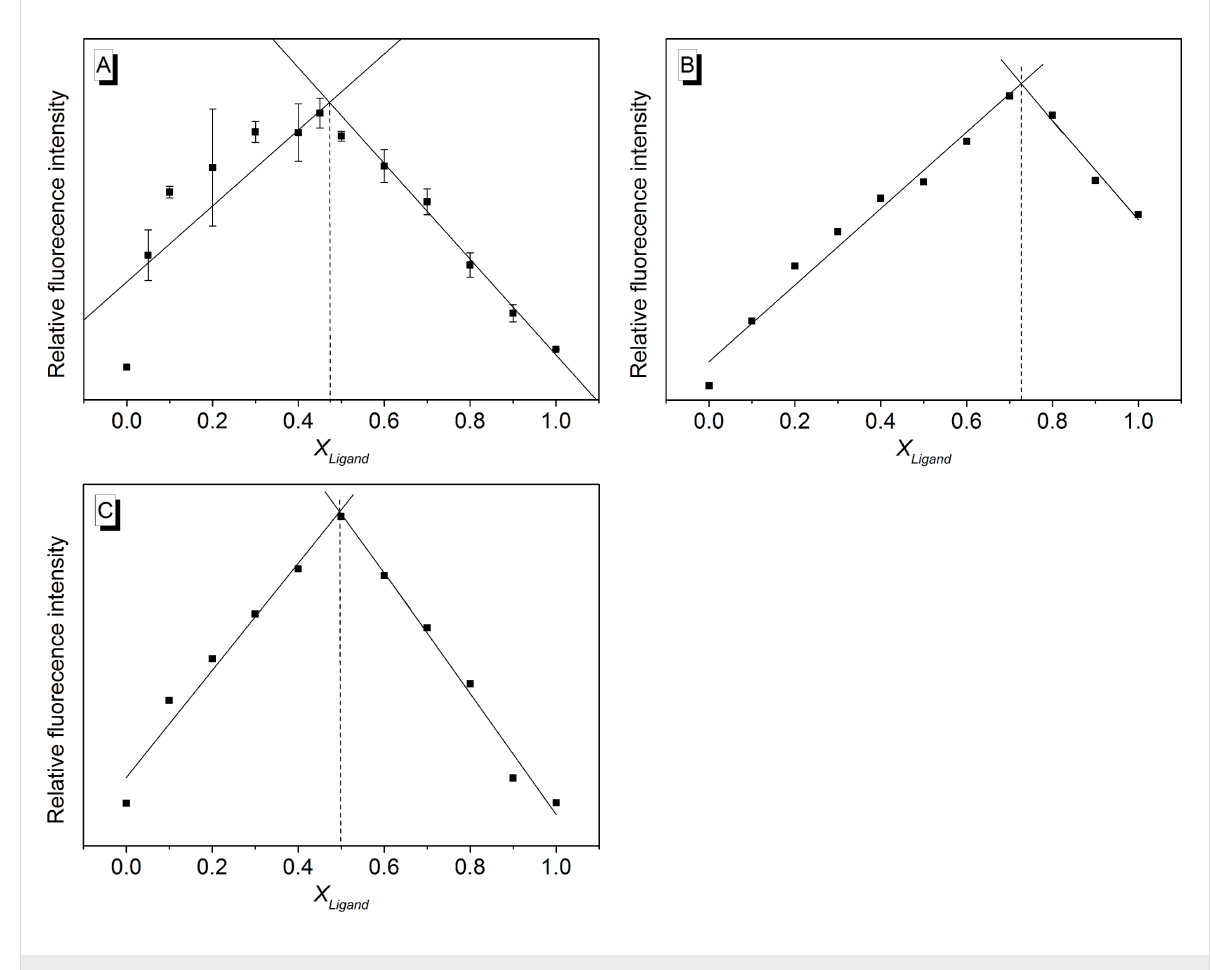
Figure 7: Job plot from fluorimetric analysis of mixtures of ligands 1e (A), 4 (B) and 6 (C) with ILPR-DNA a2 ( c Ligand + c DNA = 10.0 μ M) in potassium phosphate buffer (95 mM, pH 7.0); X Ligand = mole fraction of the ligand; A: λ ex = 580 nm; B: λ ex = 431 nm; C: λ ex = 490 nm; T = 20 °C.